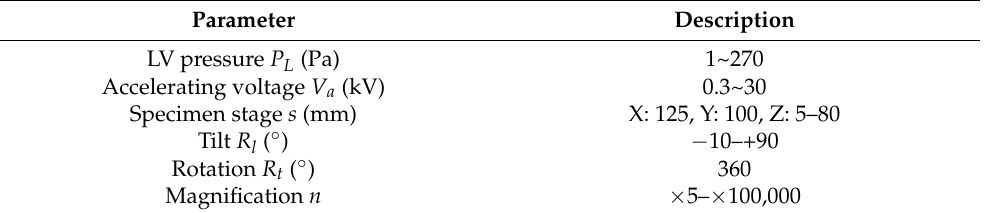
Table 3. The parameters of SEM.